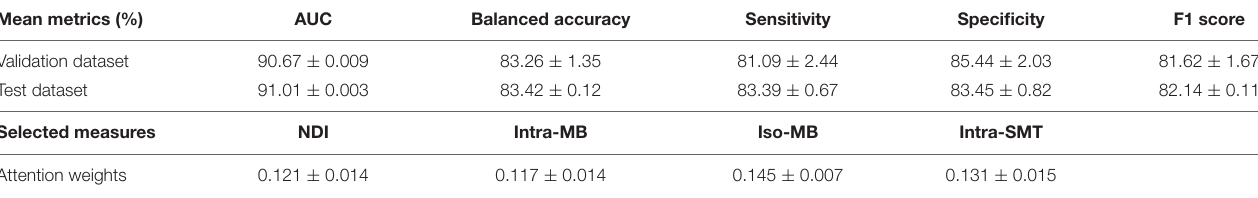
TABLE 2 | Performance of the patch-based network on MS lesions and the selected diffusion measures on fivefold cross-validation (first row, average mean, and standard deviation are reported) and pure testing set (second row). Balanced accuracy is defined as the average of sensitivity and specificity in each fold. Fl score is defined as the harmonic mean of precision and